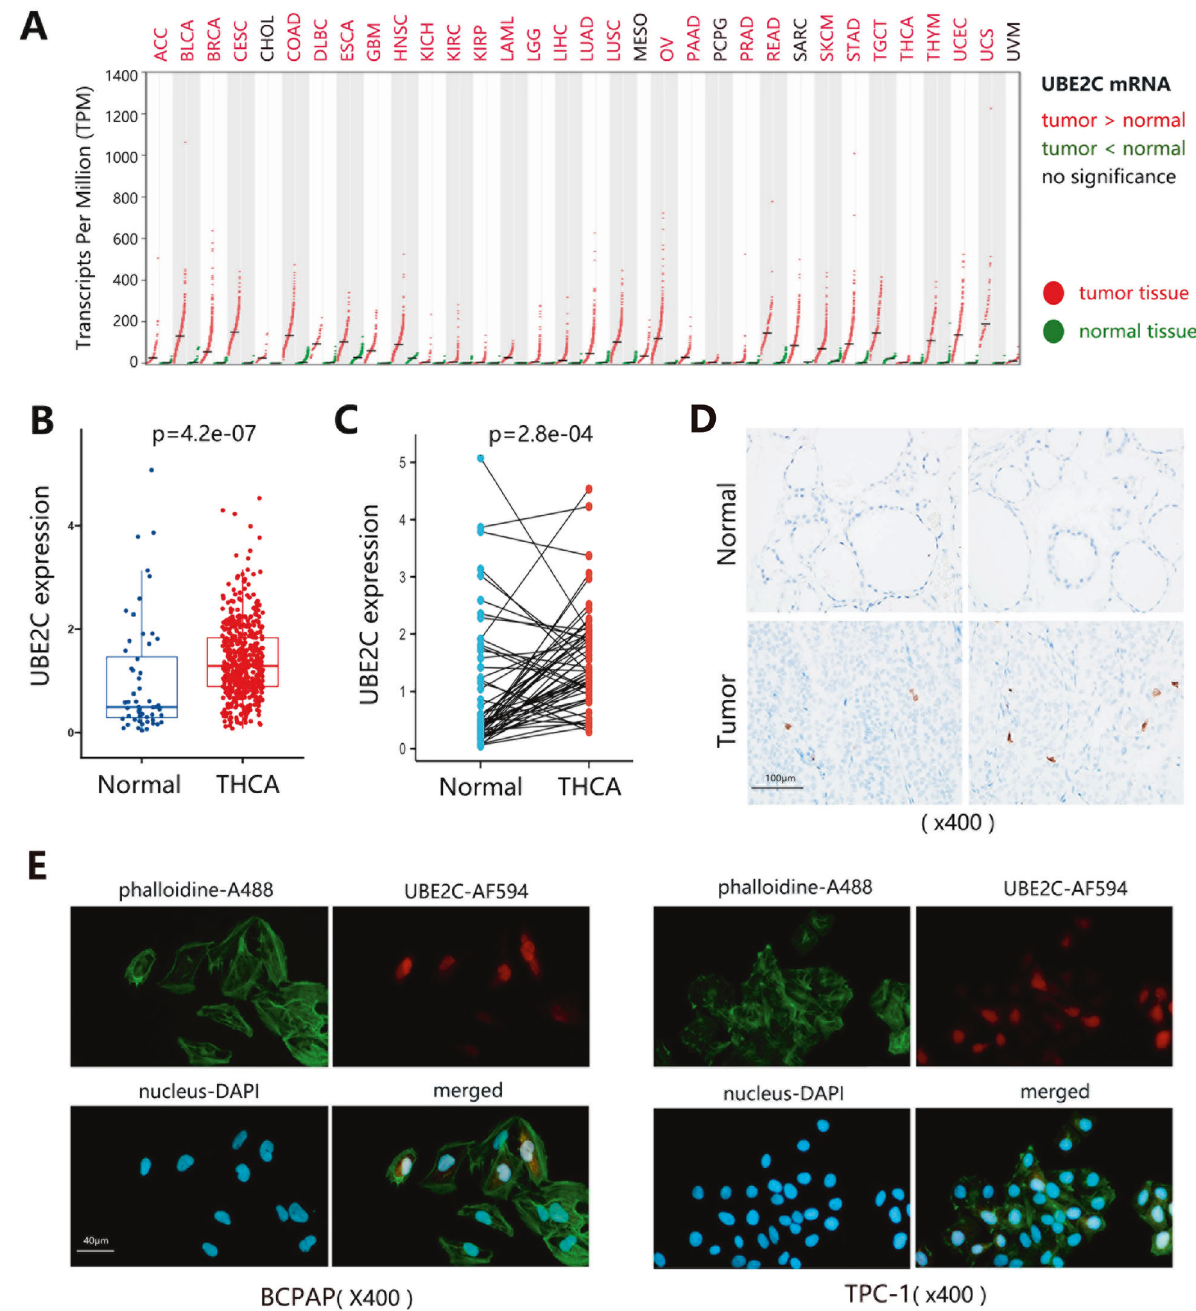
Fig. 2 The expression of UBE2C in THCA. A The mRNA expression of UBE2C across 33 human cancer types. Each dots represent the expression of samples. The color of the cancer name text indicates the expression difference and statistics. For example, the red color indicated that expression level was statistically higher in tumor tissue than in normal tissue. B Differential expression of UBE2C mRNA in normal and THCA samples. C Differential expression of UBE2C mRNA in paired samples. D Immunohistochemistry veri fi cation on protein expression of UBE2C in clinically normal and tumor samples. The blue section indicated the nucleus and the brown or tan section indicated the targeted protein UBE2C. E Subcellular location of UBE2C in tumor cells by immuno fl uorescence. The green, red, and blue fl uorescence indicated cytoskeleton, targeted protein UBE2C, and nucleus, respectively. UBE2C ubiquitin-conjugating enzyme E2 C, THCA thyroid carcinoma.